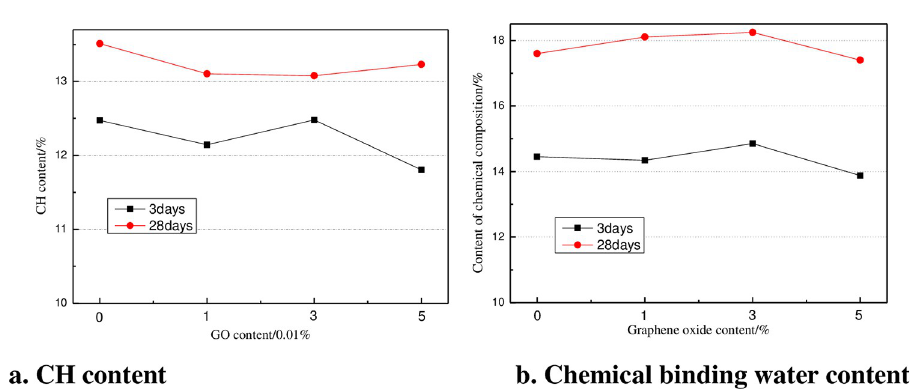
Fig 16. Contents of CH and chemical binding water of GO cement slurry at various curing